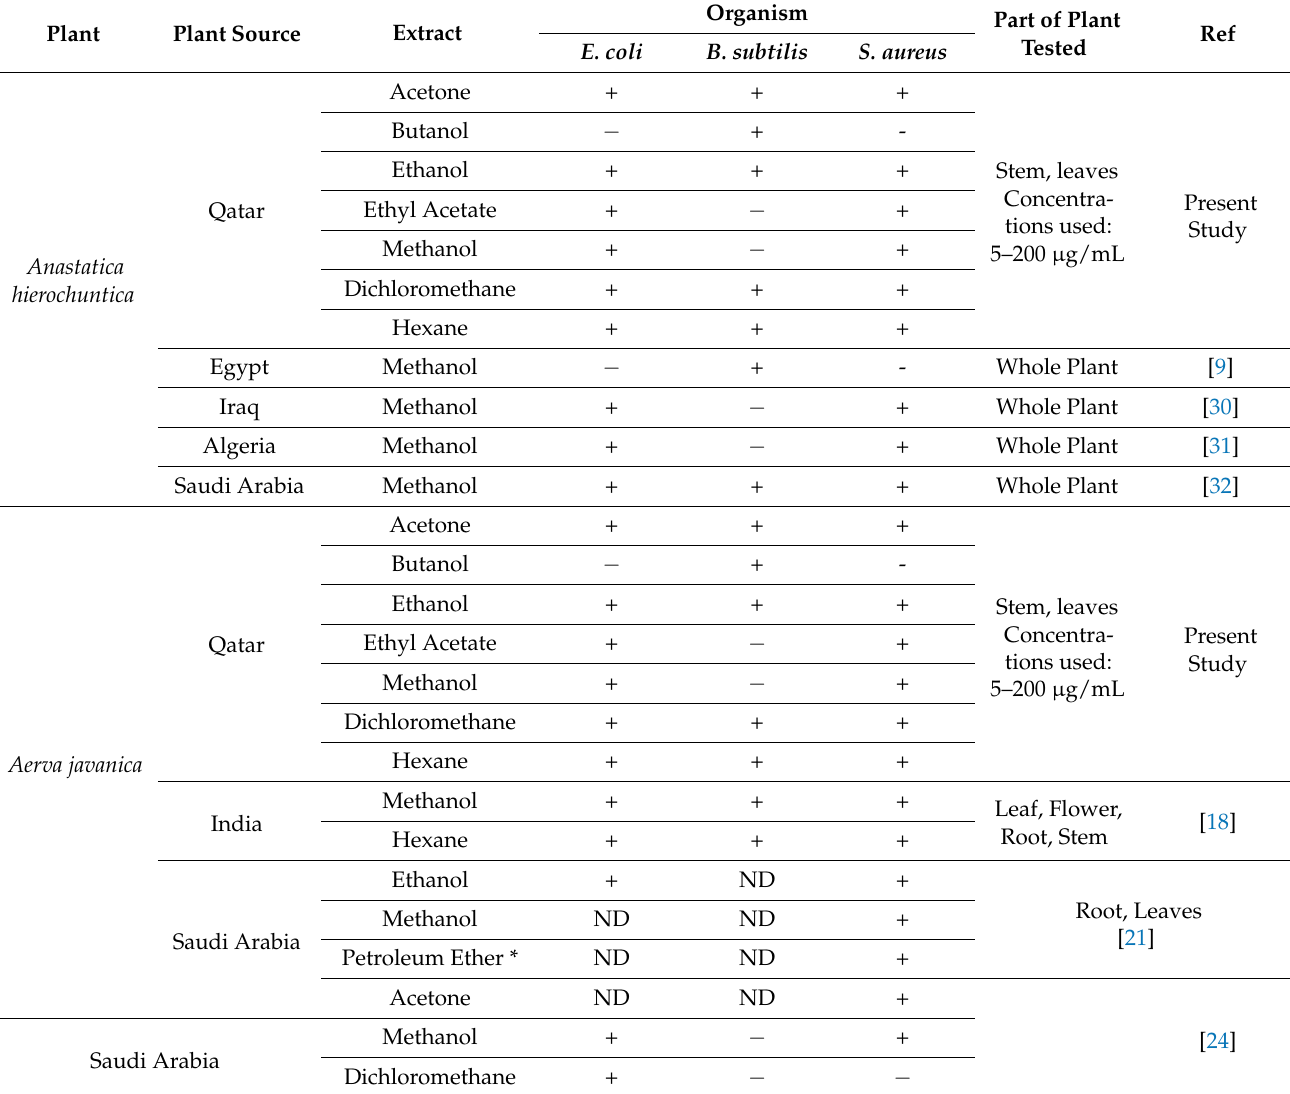
Table 3. Antibacterial activities of various extracts of Anastatica hierochuntica and Aerva javanica growing in different regions: A